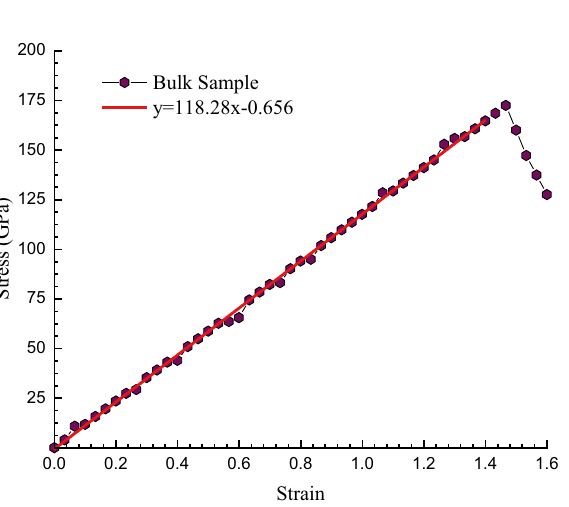
Figure 4. Stress–strain curve of a bulk sample of BAG structure at T 0 = 300 K and P 0 = 0